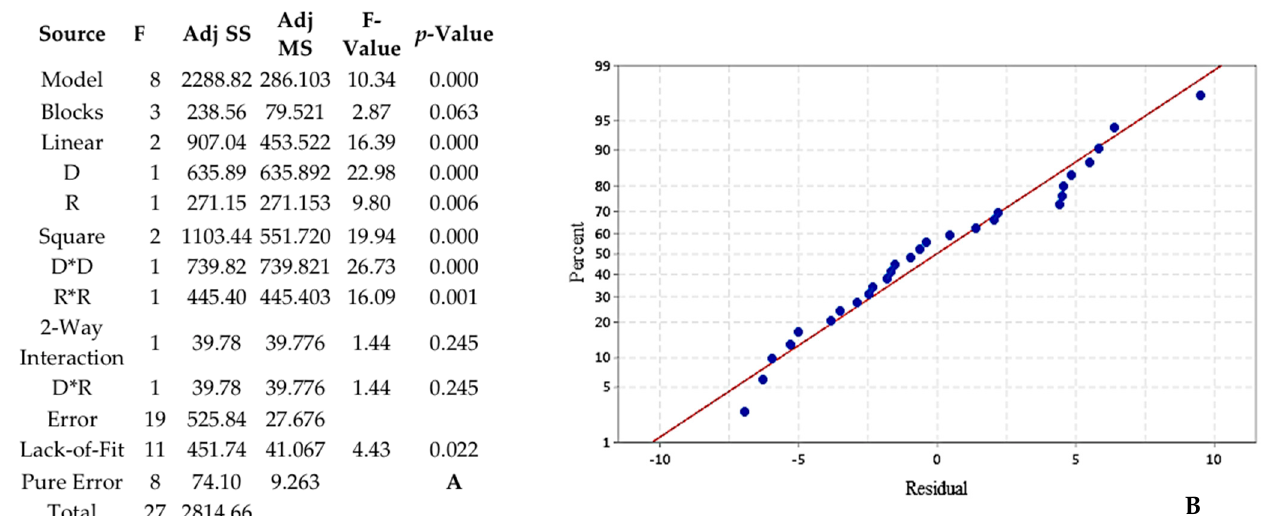
Figure 5. Analysis of variance (ANOVA) for the response surface methodology (RSM) ( A ) and normal probability plot of the residuals of GD-PPI − 3/CAN EO (2) ( B ).